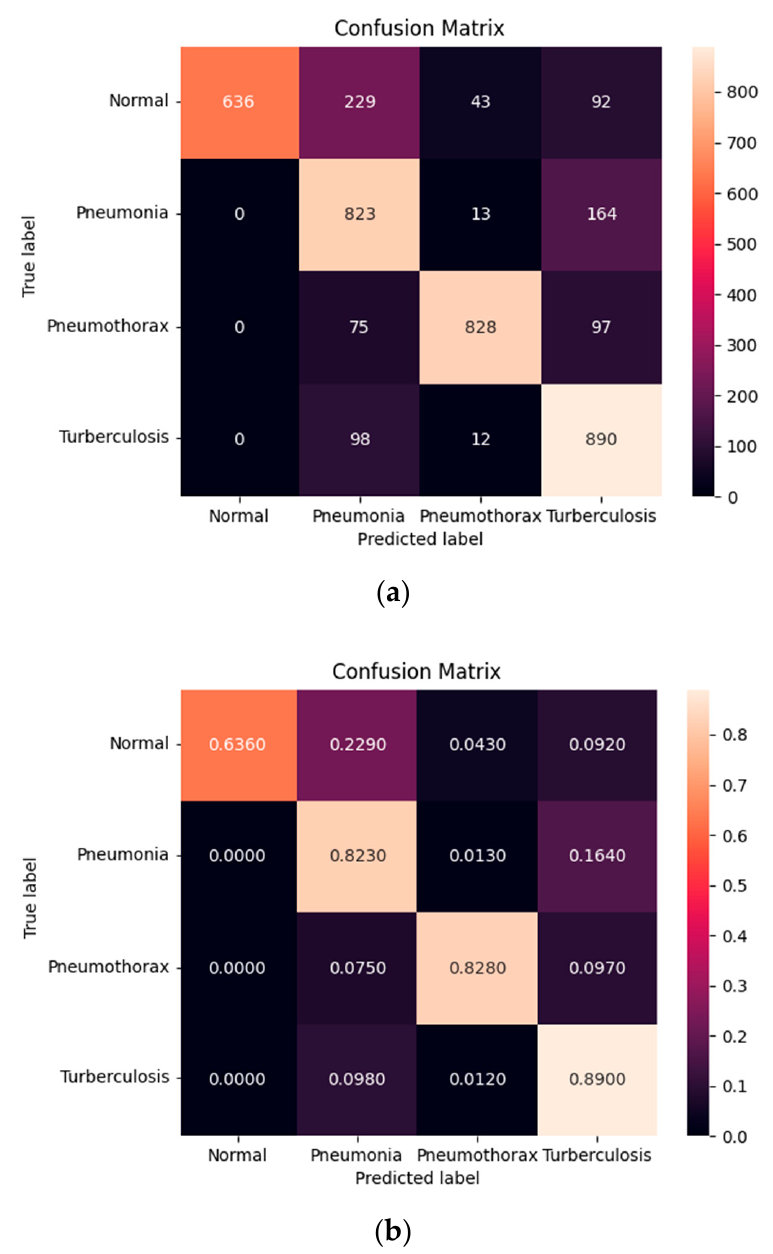
Figure 12. Confusion matrix of the Pneumonia, Pneumothorax, Tuberculosis, and Normal class of testing set of the SCH data set: ( a ) numerical; ( b ) percentage. Figure 13 depicts an example prediction for the normal, pneumonia, pneumothorax, and tuberculosis classes of the testing set of the SCH data set. The true label is shown in blue. If our prediction was correct, it will still show in blue with its confidence score. Otherwise, if our prediction was wrong, it will show in red. We predicted the first 25 images of the normal class and demonstrated their prediction scores, as shown in Figure 13a. There were 21 images that were correctly predicted (blue color) and four images that were wrongly predicted (red color). We also predicted another 25 random images of the testing set, as shown in Figure 13b. There were 21 images that were correctly predicted and four images that were wrongly